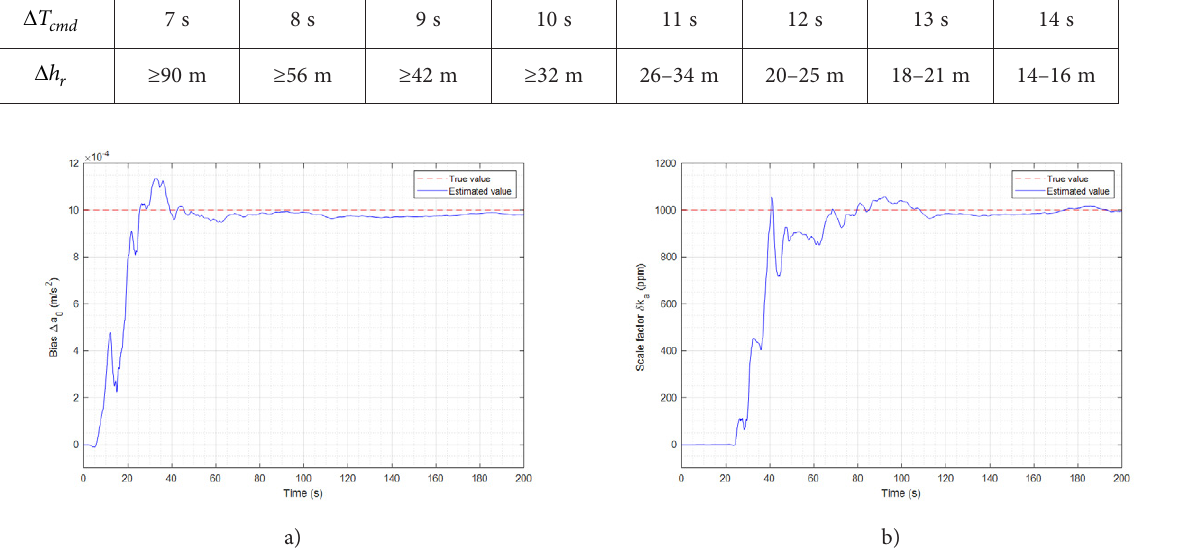
Figure 9. Calibration result with cmd T ∆ = 10 s,